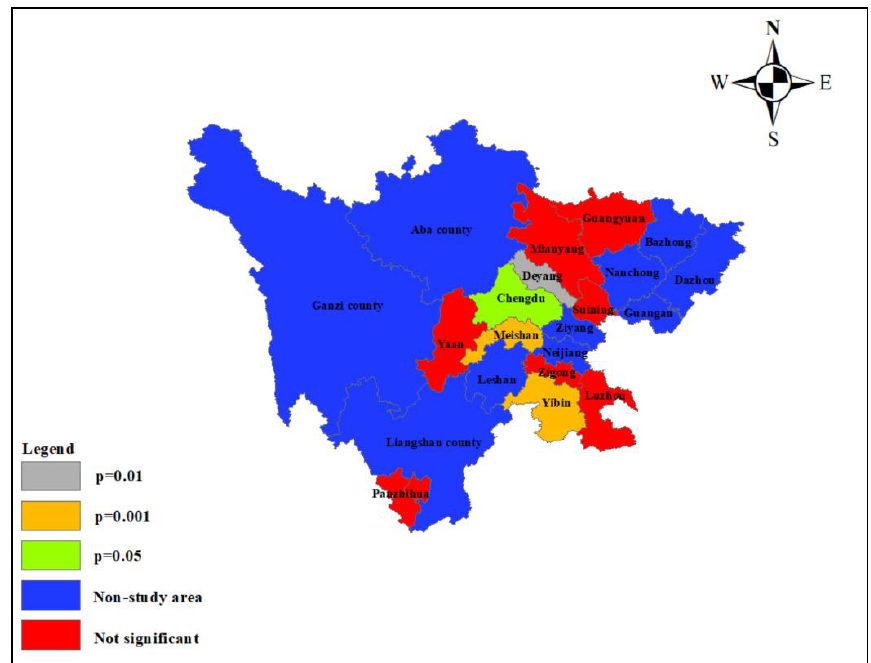
Figure 15. Reliability of local Moran’s I statistic calculation results in 2010.